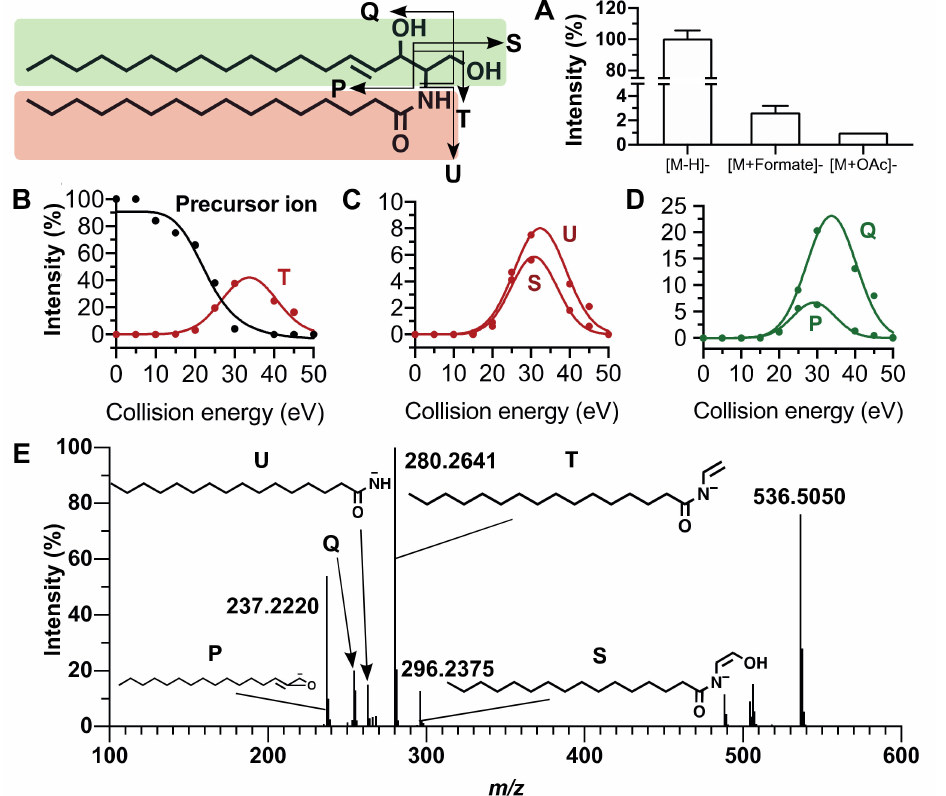
Figure 2. MS characteristics of Cer (d18:1 / 16:0). ( A ) Relative intensities of [M − H] − , [M + OAc] − , and [M + HCOO] − ions. ( B – D ) Fragmentation patterns of the [M − H] − ion formed from Cer (d18:1 / 16:0) under negative ionization conditions: relative intensities versus collision energy of ( B ) precursor ion, ( C ) fatty acyl side chains, and ( D ) sphinganine ions. ( E ) Tandem mass spectrum of Cer (d18:1 / 16:0) [M − H] − ion obtained by collision energy ramping from 20 to 40 eV. Product ions: T ( m / z 280.2646), U ( m / z 254.2486), and S ( m / z 296.259) are indicative of the fatty acyl chains; Q ( m / z 263.2379) and P ( m / z 237.2225) are indicative of the sphingosine moiety. Product ions are labelled according to Reference [37]. Green and red colors relate to sphingosine and fatty acyl position,